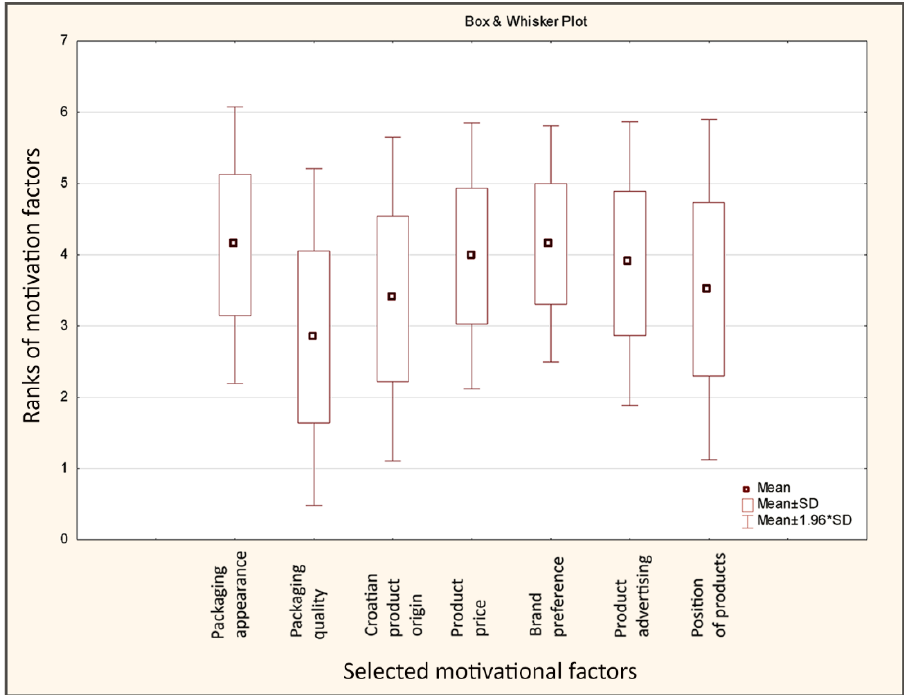
Figure 3. Box & Whisker impact chart of selected variables on selection and purchase of food prod- ucts.